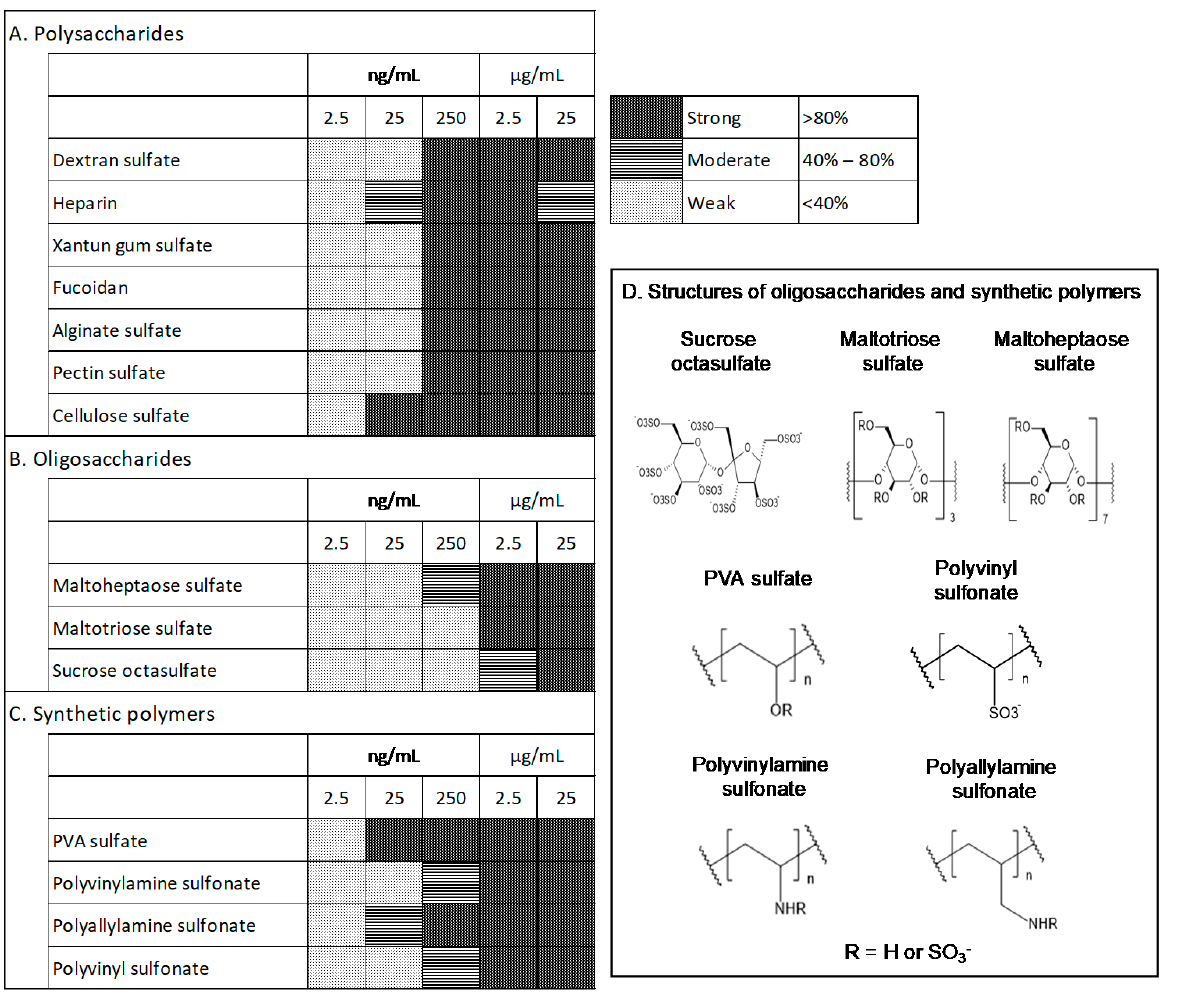
Figure 2. Effects of sulfated/sulfonated compounds on bFGF stabilization. Based on ELISA, as shown in Figure 1, the effective concentrations of sulfated/sulfonated polysaccharides ( A ), oligosaccharides ( B ), and synthetic polymers ( C ) for bFGF stabilization in E8 medium are shown. The structures of the sulfated/sulfonated oligosaccharides and synthetic polymers tested are also shown ( D ); R indicates H or SO 3 − . Samples were prepared in triplicate and analyzed. Microsoft Excel for Microsoft Apps for Enterprise was used for preparation of the